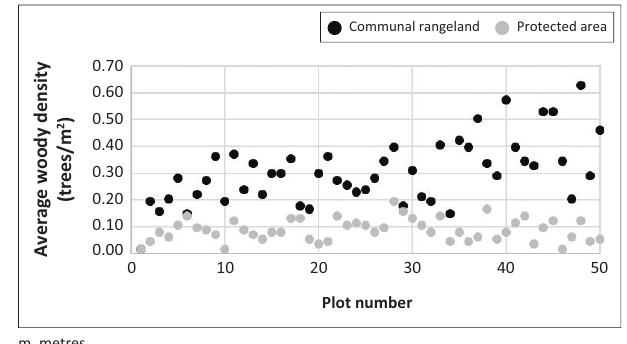
FIGURE 3-A1: Scatter plot showing the average woody density of trees > 0.5 m per plot number of each land-use type (protected areas versus communal rangelands) Plot number increases with distance from water source (protected area) or gate (communal